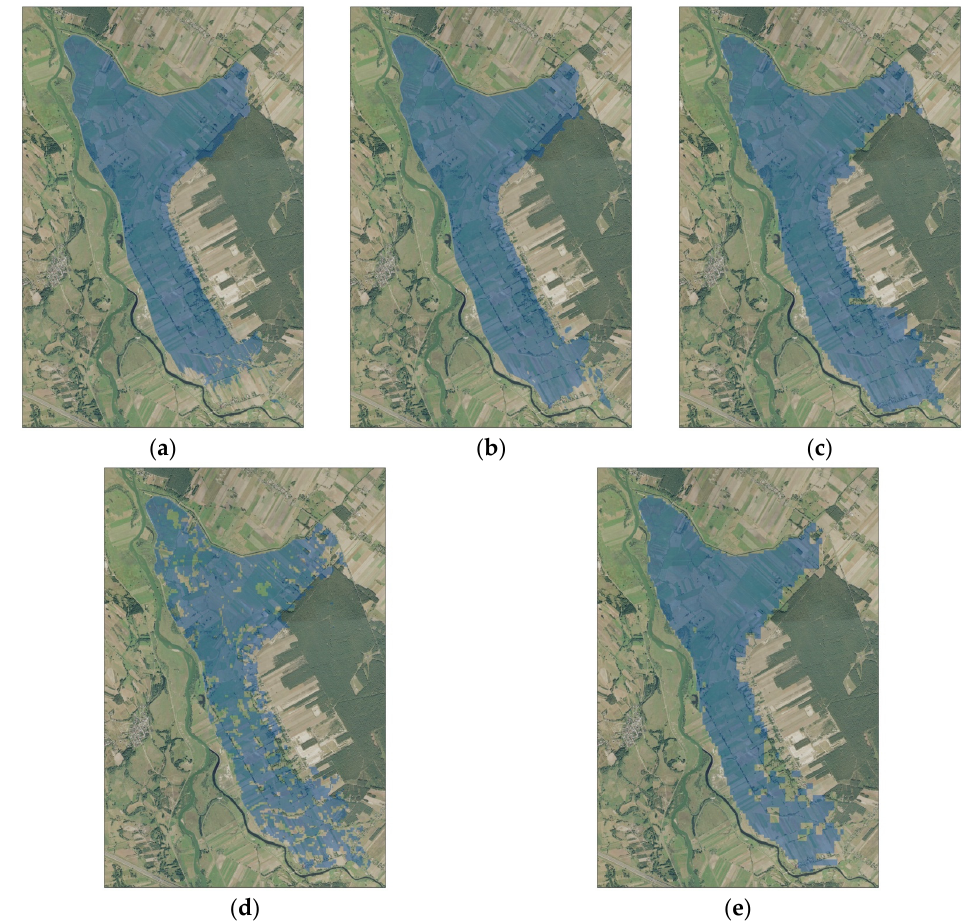
Figure 9. Flood zone of the specific DEMs (LIDAR, Airborne, ASTER, SRTM and SRTM_cor) for the maximum ordinate of 94.4 m a.s.l., ( a ) LIDAR-DEM; ( b ) Airborne-DEM; ( c ) ASTER-DEM; ( d ) SRTM-DEM; ( e ) SRTM-DEM + correction 2.67 m.